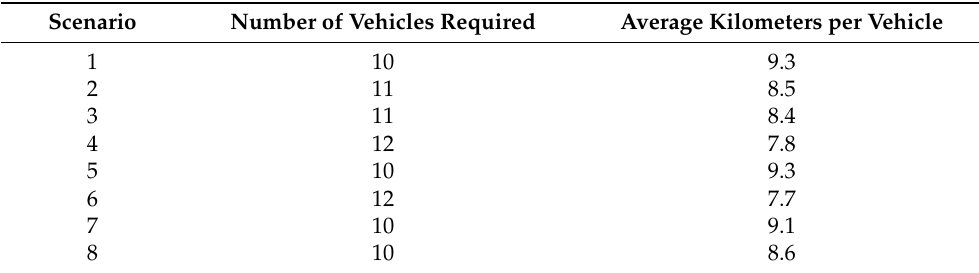
Table 9. Fuel truck, vehicle number, and kilometers covered per